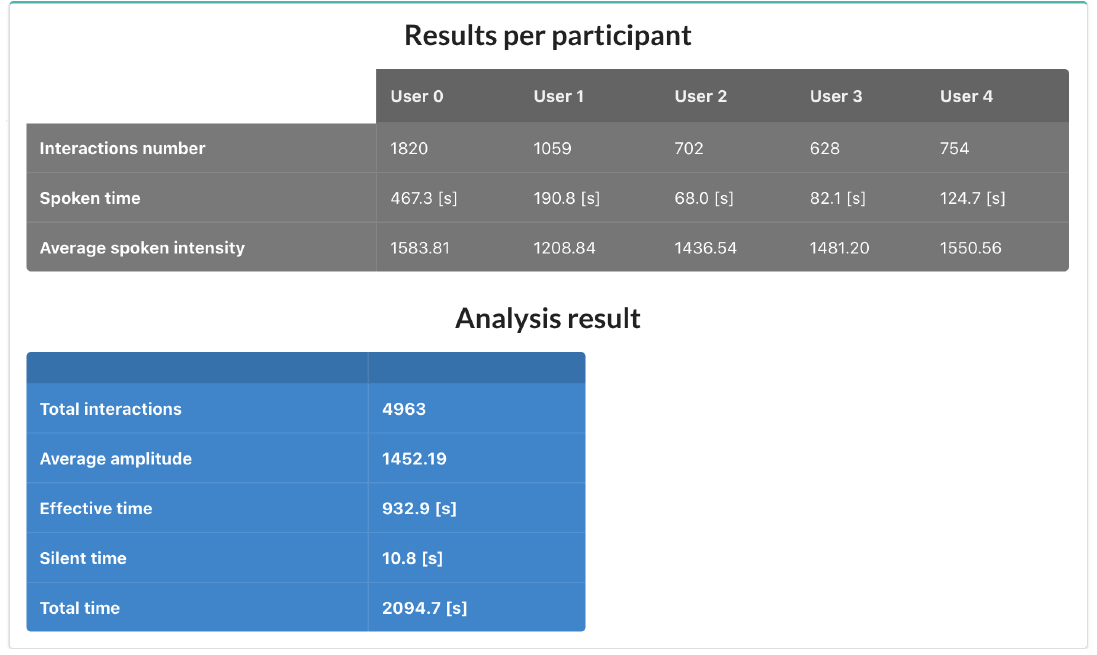
Figure 3. Summary of analyzed data of